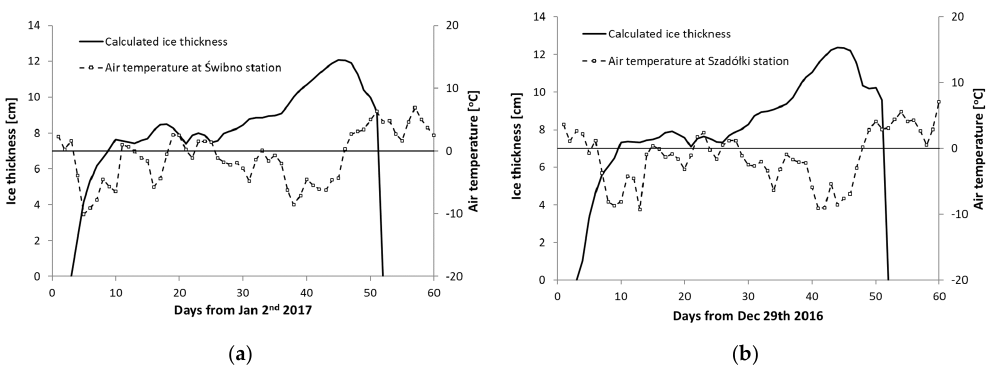
Figure 3. Calculated thickness of the ice cover on the Łapino reservoir in the winter season 2016/2017 based on the sum of negative temperatures of the IMWM station in ( a ) Ś wibno and ( b ) Szadó ł ki.